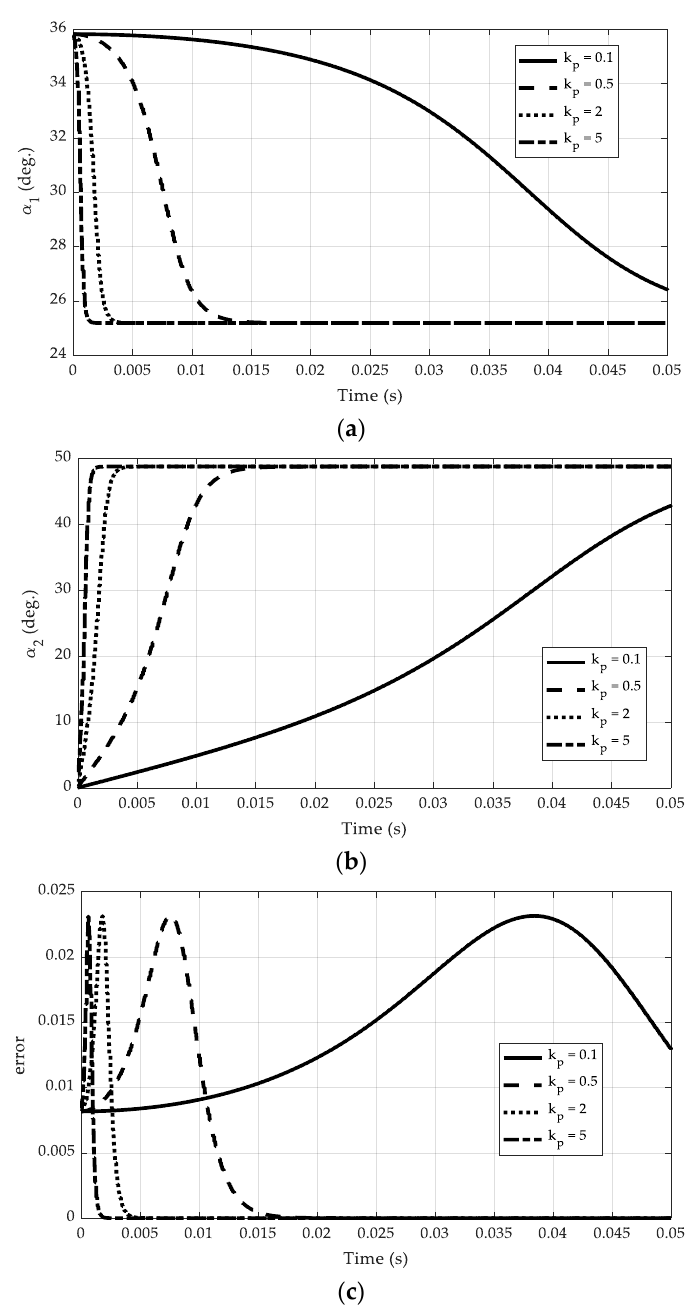
Figure 3. The effect of the k p changes on ( a ) switching angle α 1 , ( b ) switching angle α 2 , and ( c ) error signal.